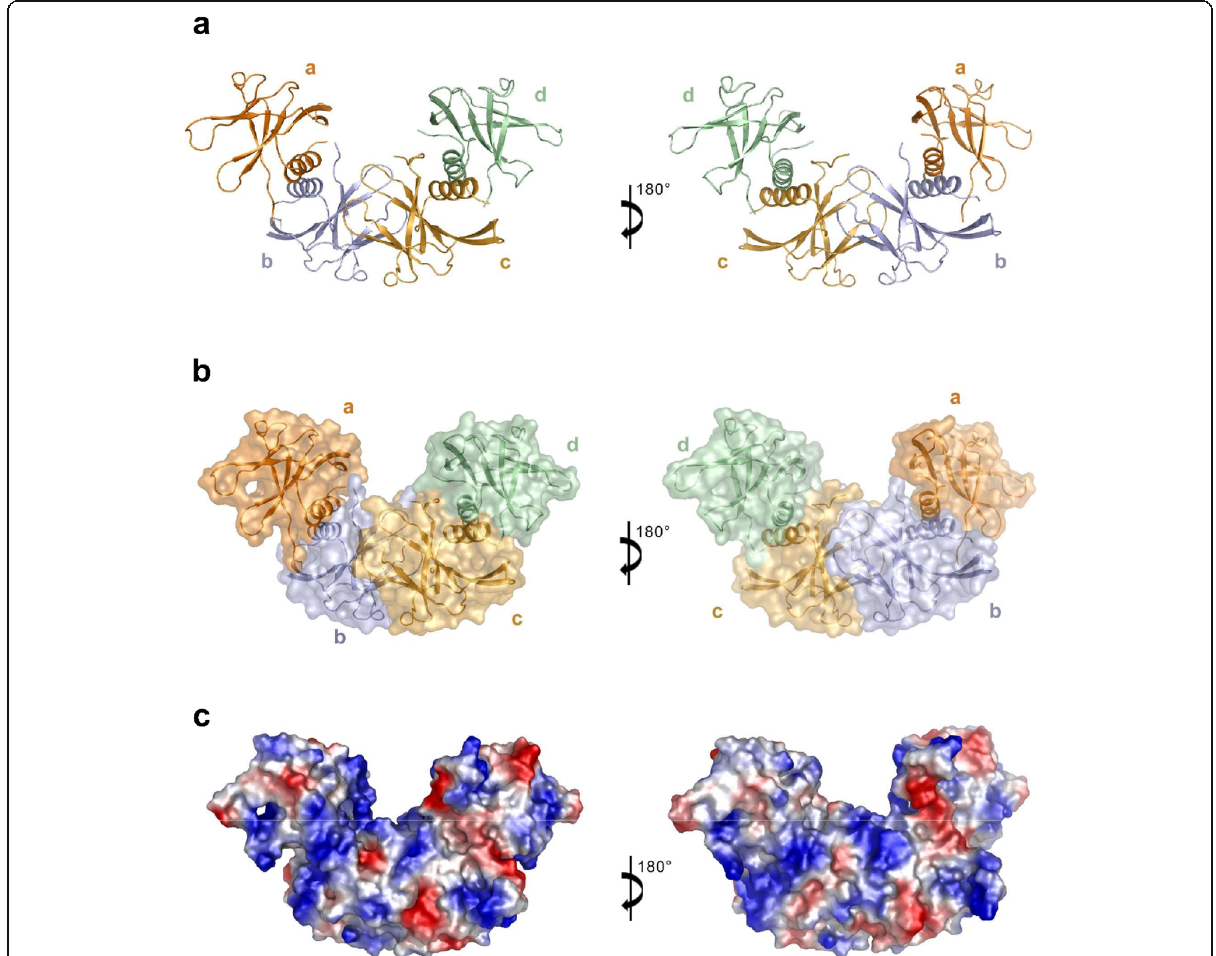
Fig. 2 Structure of the SARS-CoV-2 nsp9 tetramer. a Architecture and assembly of the nsp9 tetramer. Molecules a, b, c, and d in the stable tetramer are colored in orange, light blue, bright orange and pale green, respectively, and depicted in cartoon representations. b The stable tetramer is colored, labeled as Fig. 2a and depicted in cartoon and surface representations. c The electrostatic potential surface of the stable tetramer. Blue, positive charge (+ 70 k B T); Red, negative charge ( − 70 k B